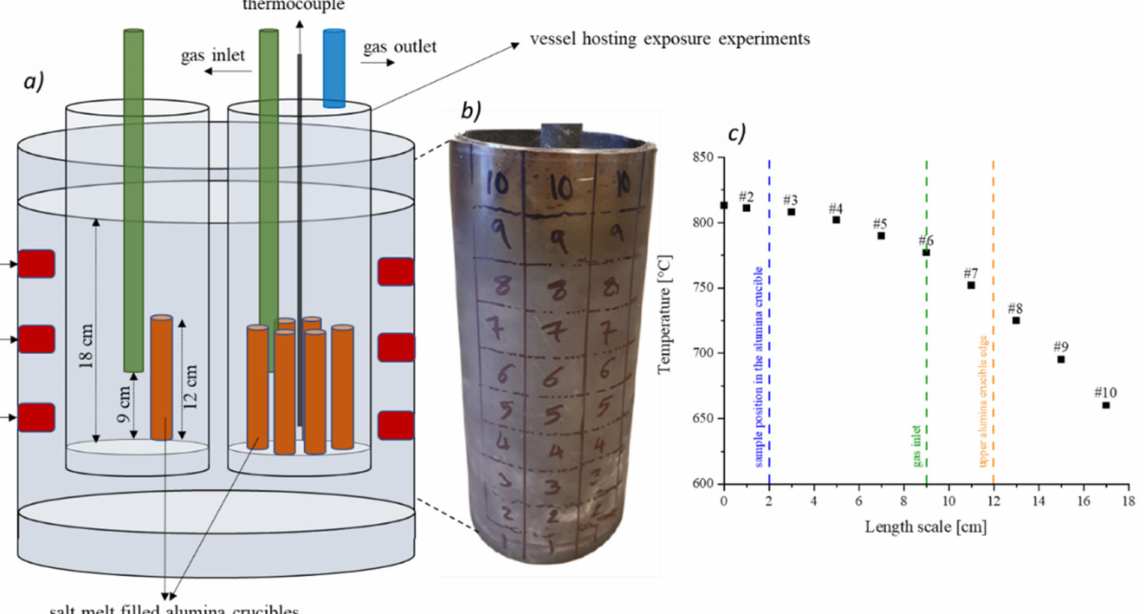
Figure 1. ( a ) Schematic illustration of the furnace setup showing the design for two vessels, gas supply, and crucible position for immersion tests in molten salt. ( b ) Image of the decommissioned vessel with sample sections drawn outside. ( c ) Temperature profile within the vessel during operation at 800 ◦